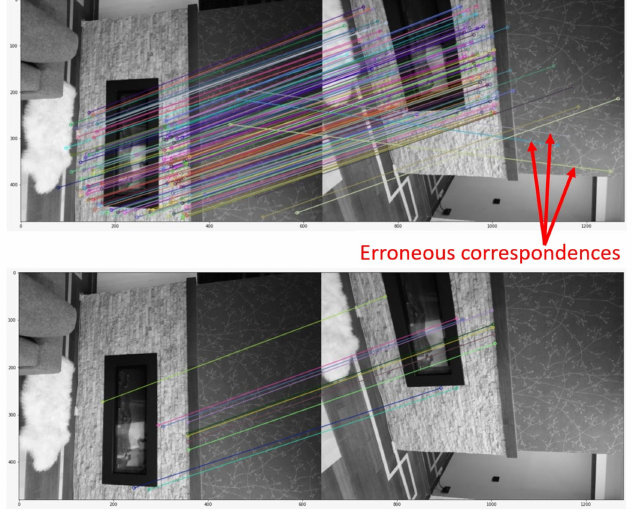
Figure 6. Correspondences detected with matching algorithms: results of the FLANN algorithm ( top ) and of the BFMatcher ( bottom